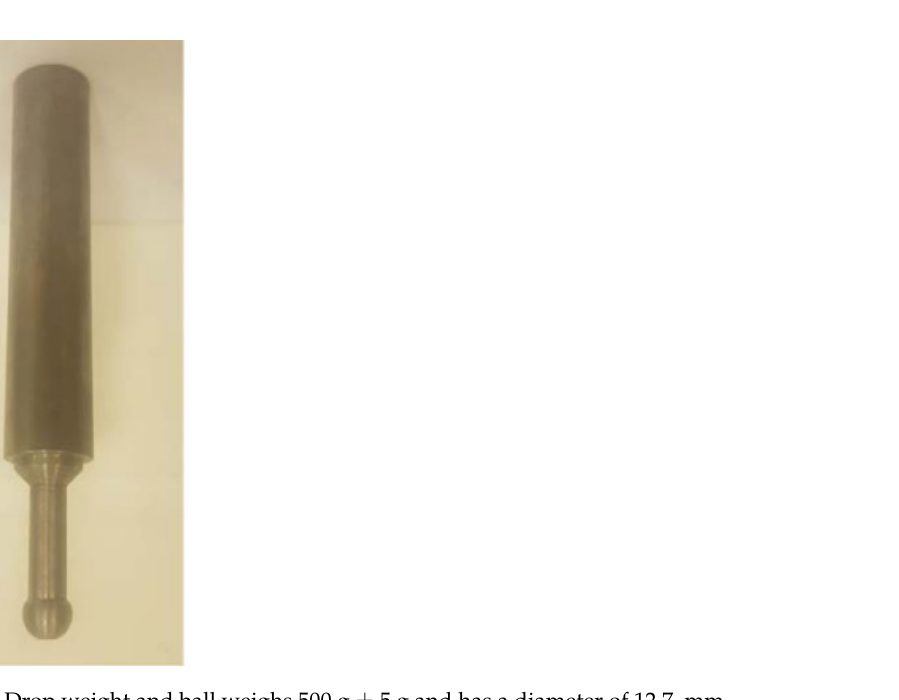
Figure 4. Drop weight and ball weighs 500 g ± 5 g and has a diameter of 12.7 mm.